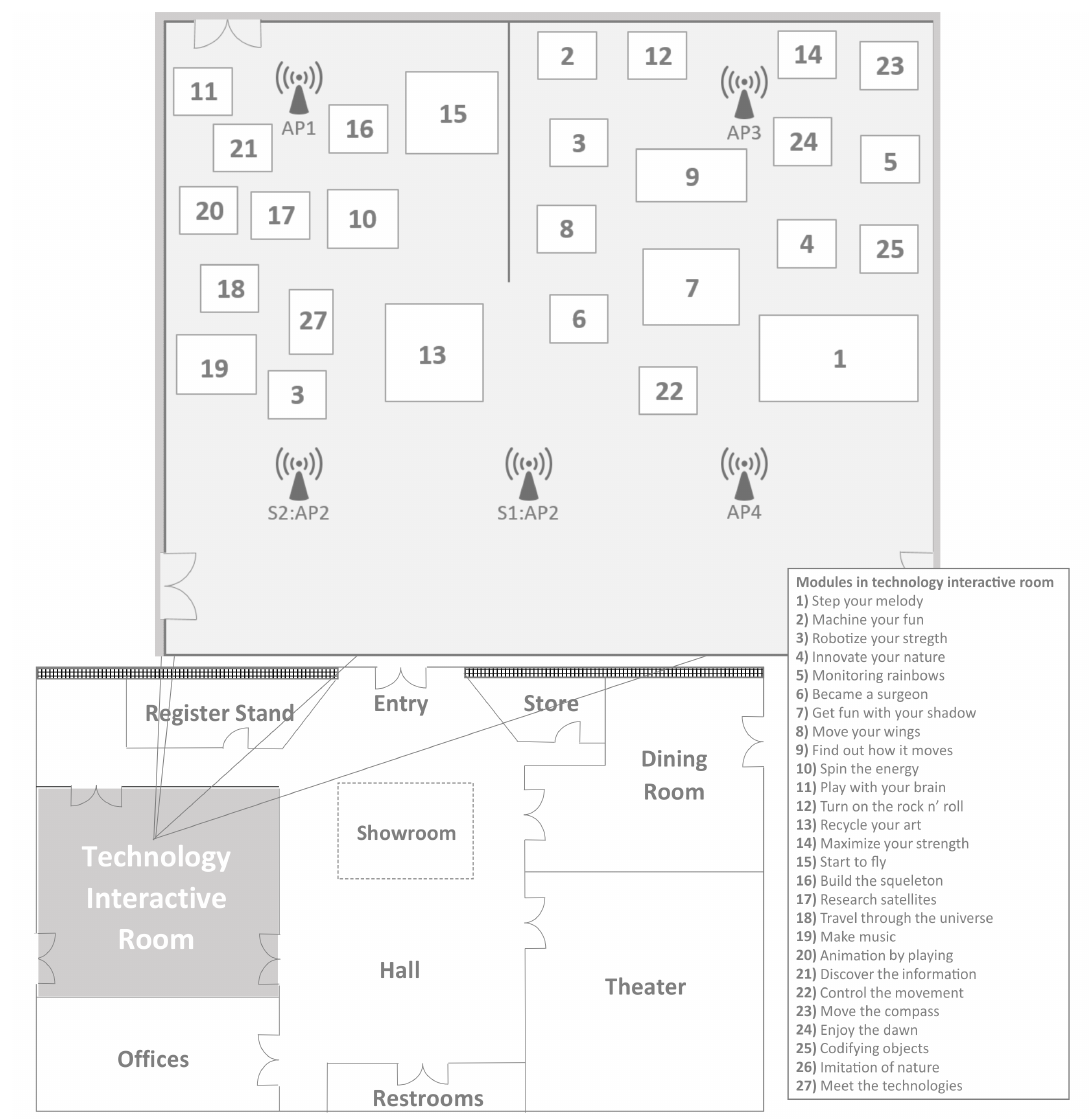
Figure 6. The museum’s 1st floor for the Indoor location methods (ILM)